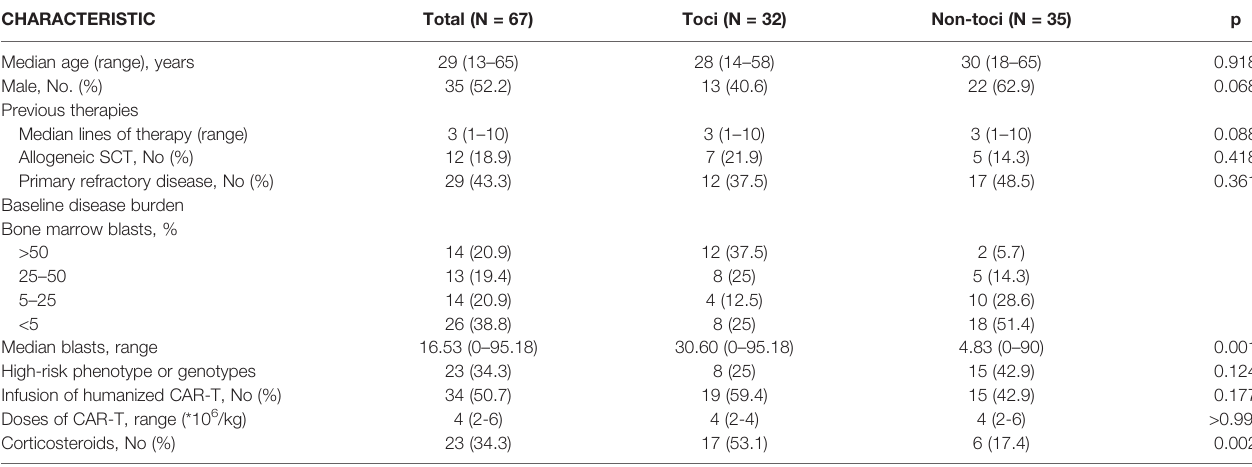
TABLE 1 | Characteristics and treatment of patients and comparison of subgroups. CHARACTERISTIC Total (N = 67) Toci (N = 32) Median age (range), years